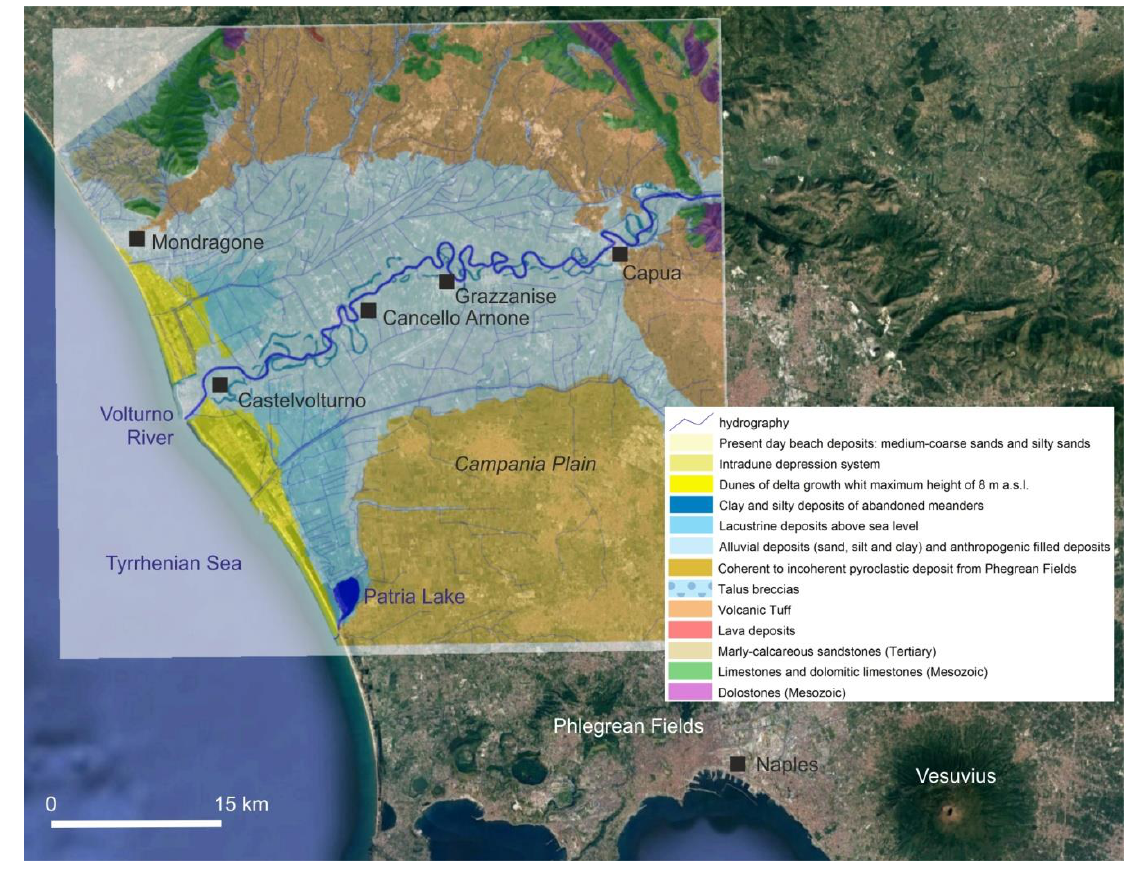
Figure 2. Schematic geologic map of the study area.